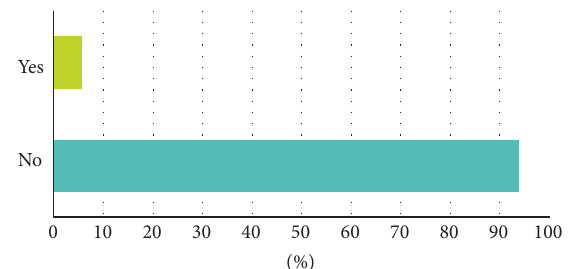
Figure 2: Example question taken from the survey, answers in per- cent.